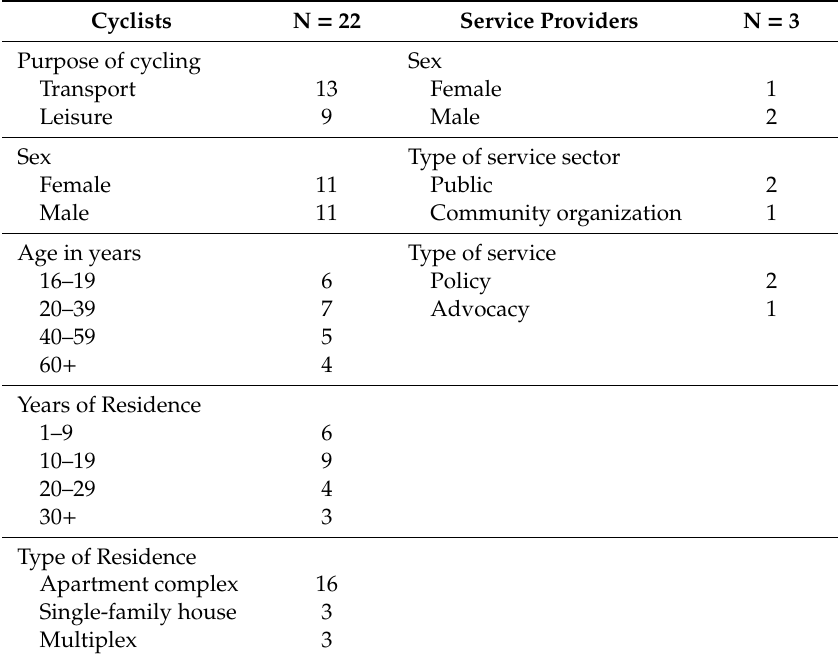
Table 1. Participants’ socio-demographic